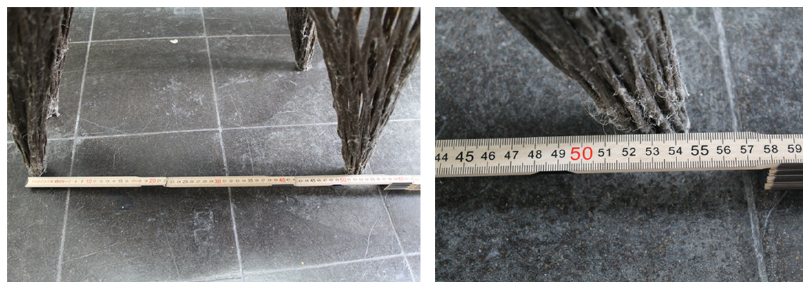
Figure 22. Sitting test measurements after sitting 54.5 cm